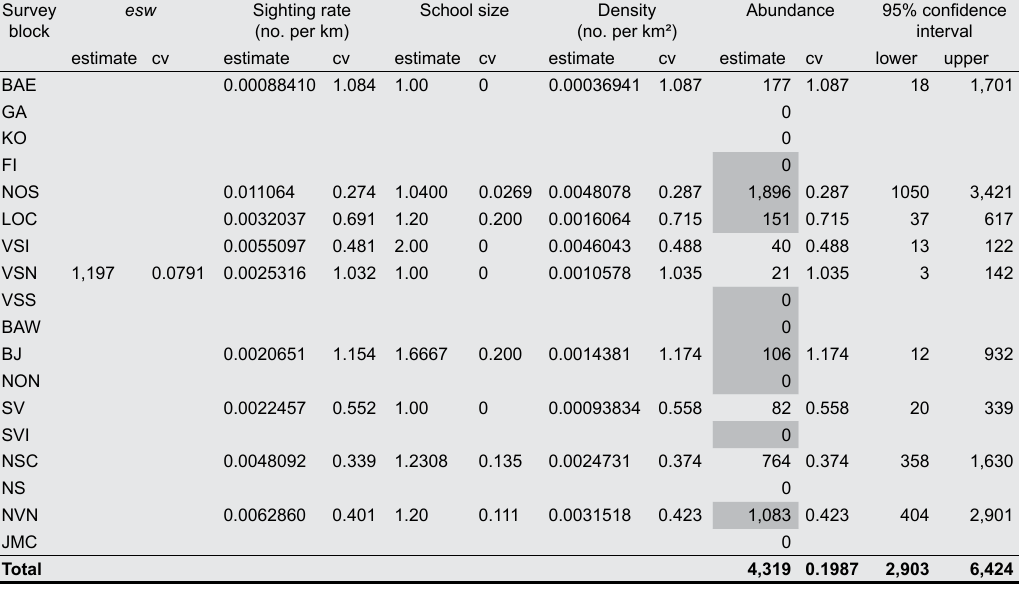
Table 10. Estimated abundance for sperm whales for the shipboard survey in 1995, based on the combined data from platforms 1 and 2. Estimates that include single-platform effort are shaded. Survey esw Sighting rate block (no. per km) estimate cv